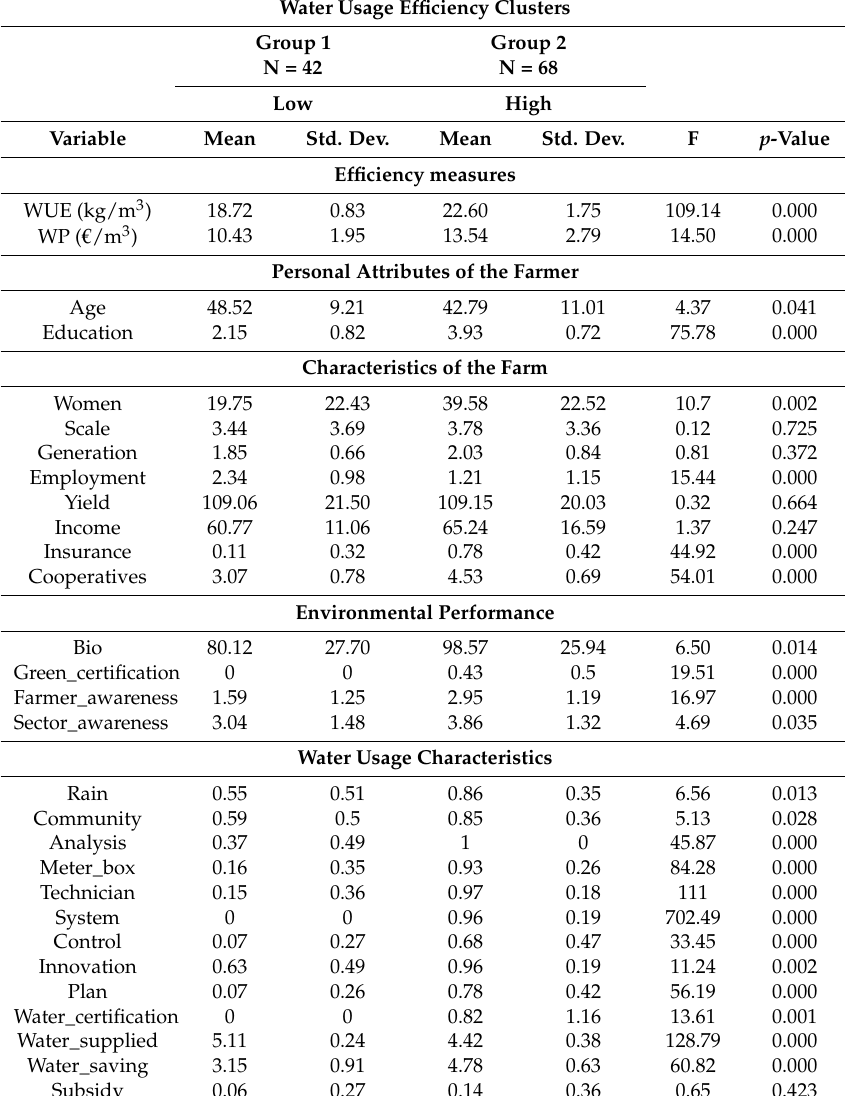
Table 3. Characteristics of identified clusters of farms and test statistics of one-way